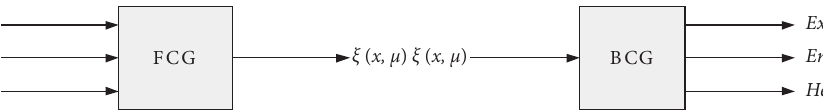
Figure 2: Cloud generators.